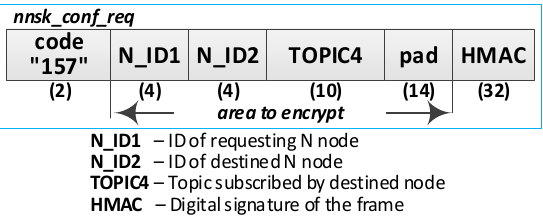
Figure 27. The frame of session key confirmation request.